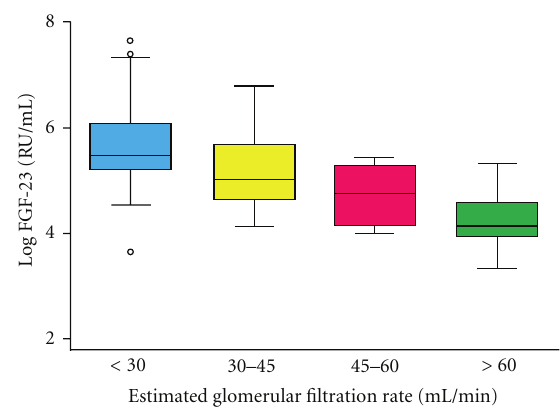
Figure 1: Serum fibroblast growth factor (FGF)-23 levels are negatively associated with estimated glomerular filtration